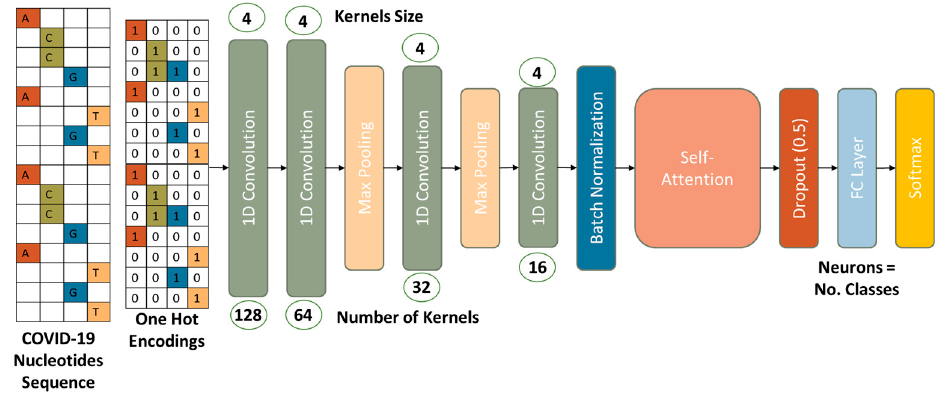
Figure 2. The proposed self-attention 1D-CNN network for COVID-19 variant classification.